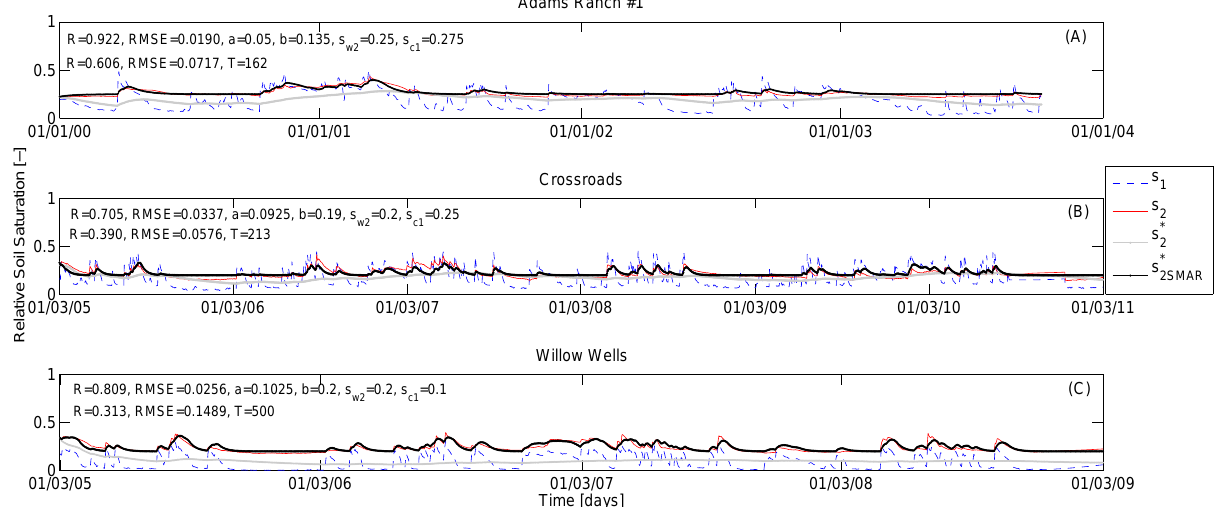
Fig. 9. Comparison between the relative saturation of the surface soil layer ( s 1 ) and the averaged value over the first 90cm of depth ( s 2 ), the filtered value ( s ∗ ) obtained with SMAR and the filtered value obtained with the exponential filter ( s ∗ 2SMAR Adams Ranch #1 (A) , Crossroads (B) , and Willow Wells (C) , respectively. Results describe the application of SMAR and the exponential filter (SWI) method, where all parameters have been calibrated optimizing the RMSE.